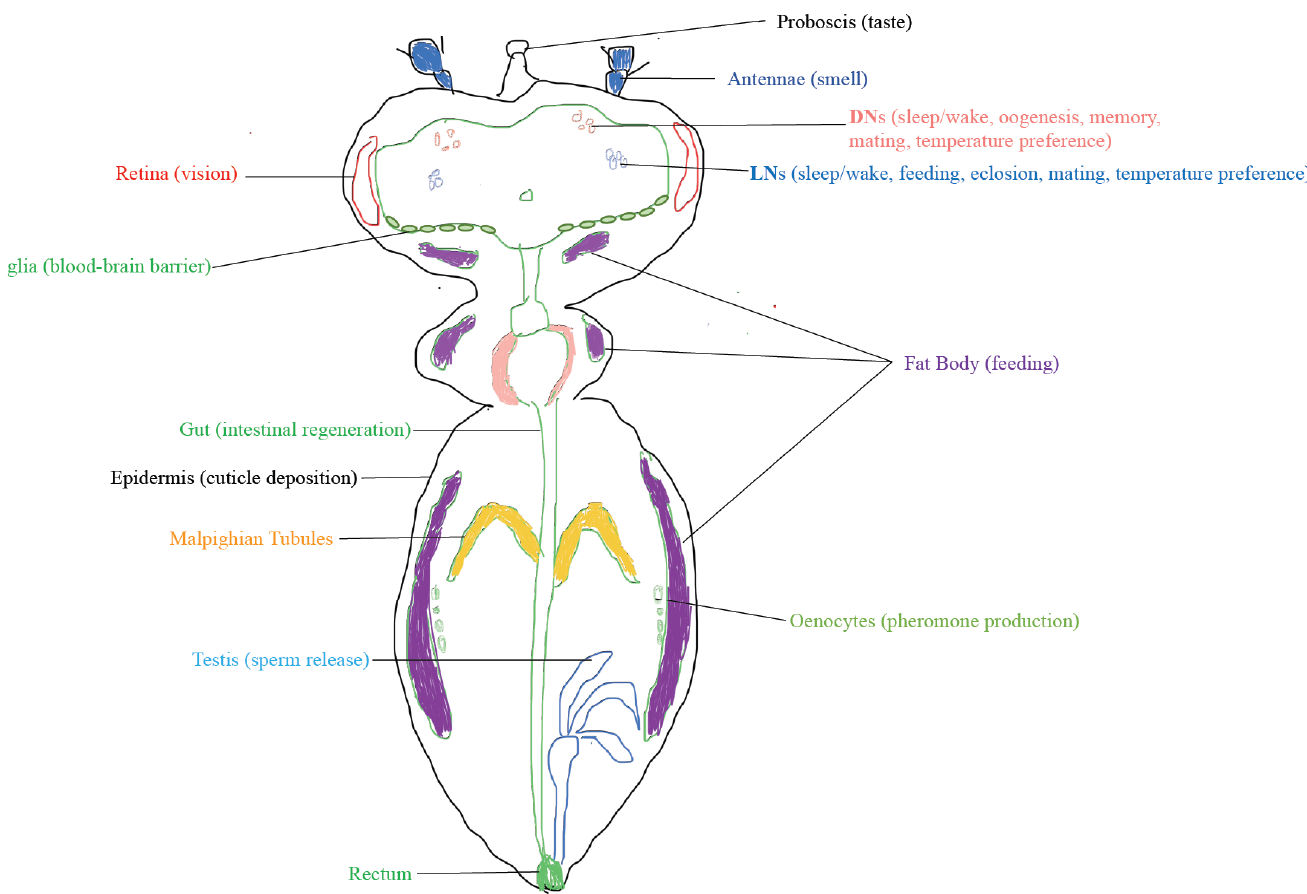
Figure 1. Pervasive clock-driven physiologies. Clock-regulated diurnally varying biological processes are observed all over the fly body. While the clocks in the brain (LNs and DNs) regulate multiple behaviours such as sleep/wake, mating and feeding, the peripheral clocks often regulate local physiologies—either in consultation with the central brain clock, or autonomously. However, for a number of peripheral clocks, the physiological outputs that they regulate, are yet to be known.